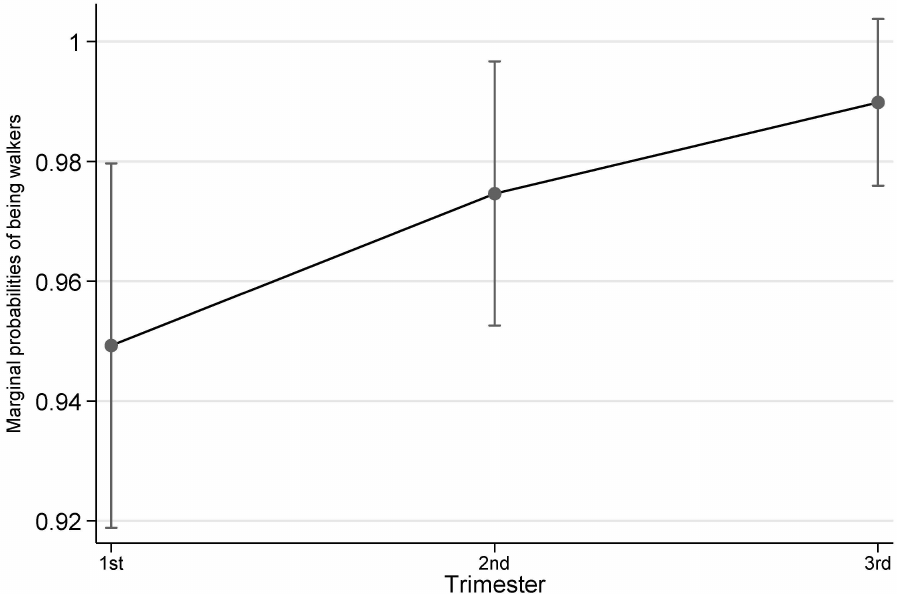
Figure 2. Probability of being walkers by trimester. Notes: The error bars represent 95% confidence intervals of the corresponding point